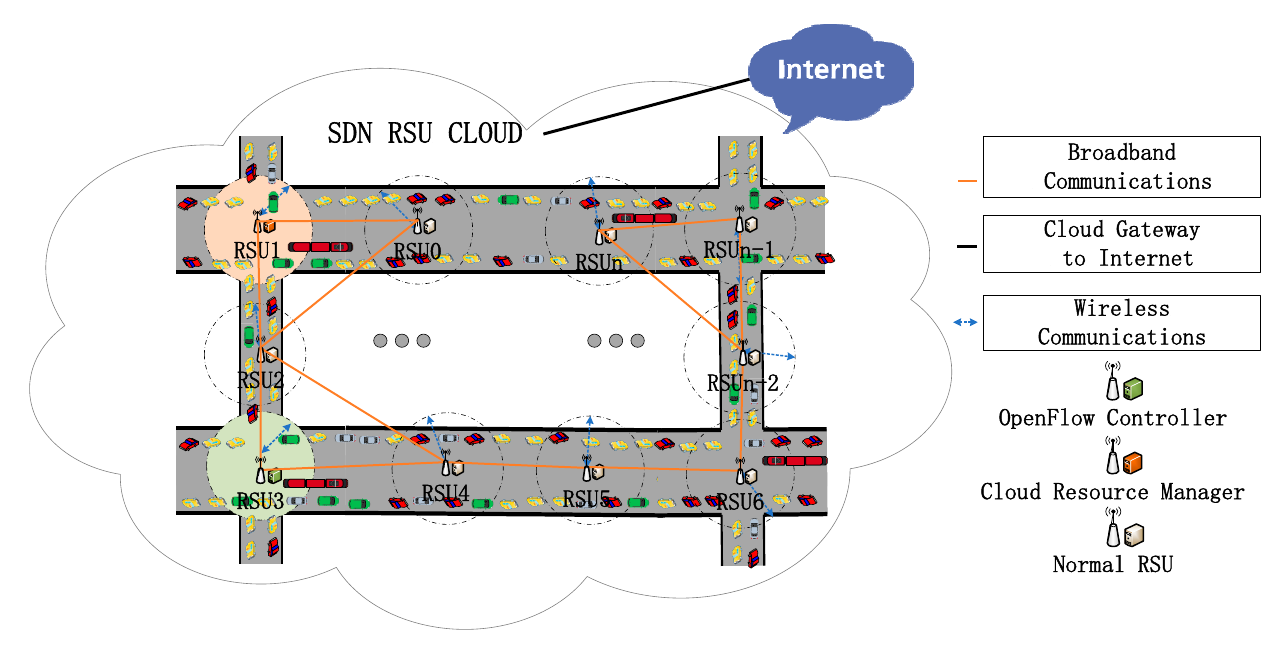
Figure 2. Schemes of the SDN RSU cloud.